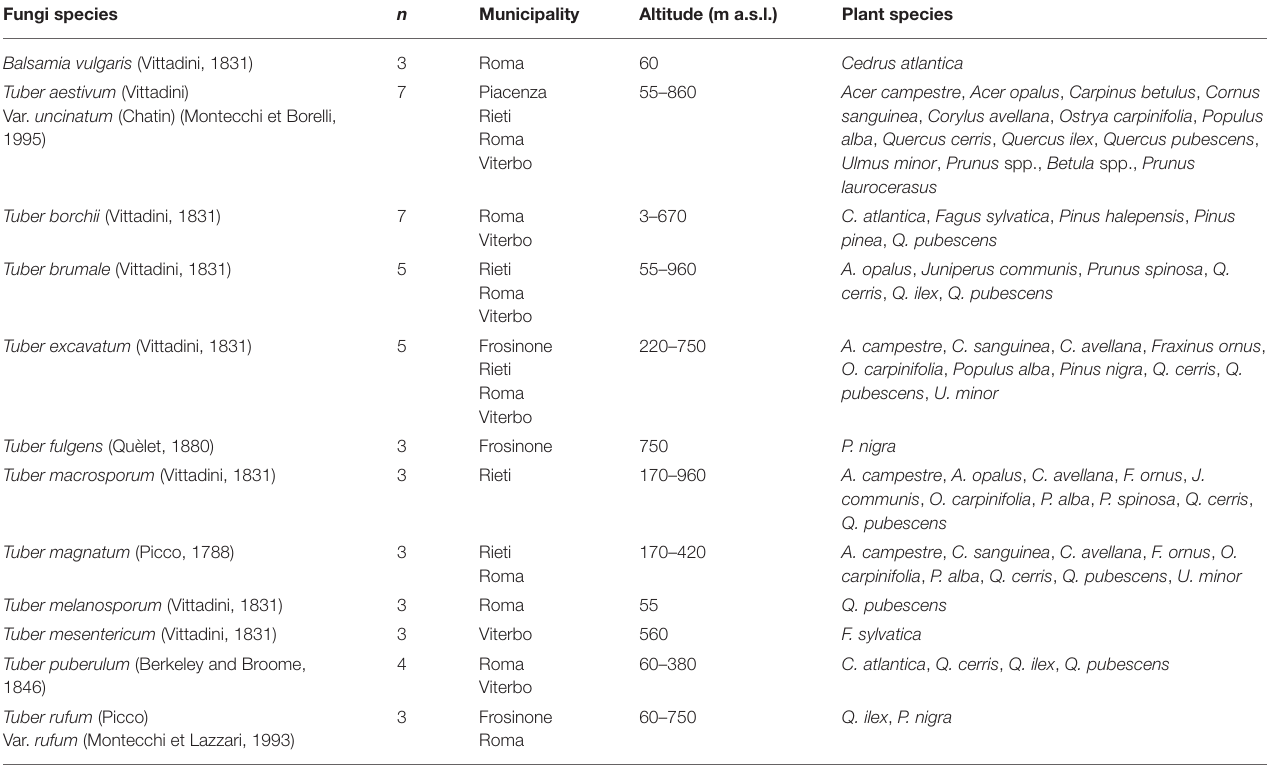
TABLE 1 | Species of hypogeous fungi used in the study, number of fungi per species, municipality, altitude of the area, and plant species present in the area. Fungi species n Altitude (m